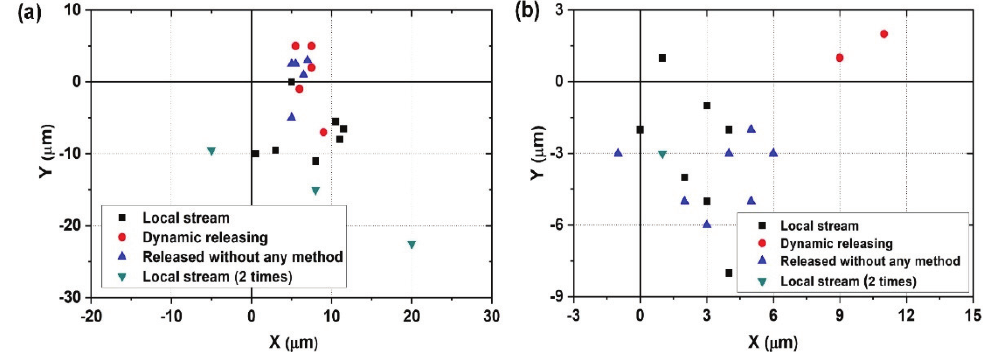
Figure 9. Result of the automated manipulation of an object; ( a ) Placing position of 100 μ m microbeads; ( b ) Placing position of 55 μ m microbeads. ( b ) Placing position of 55 µ m